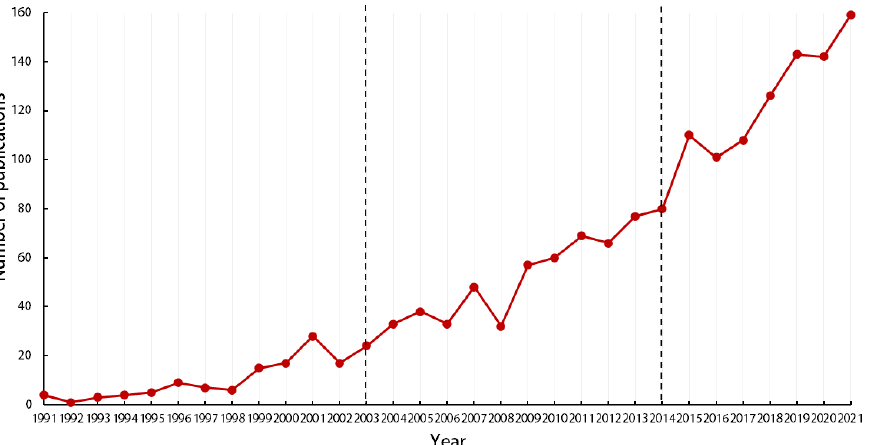
Figure 4. The annual number of publications on agricultural land function in the WOS Core Collec- tion (1991 – 2021).